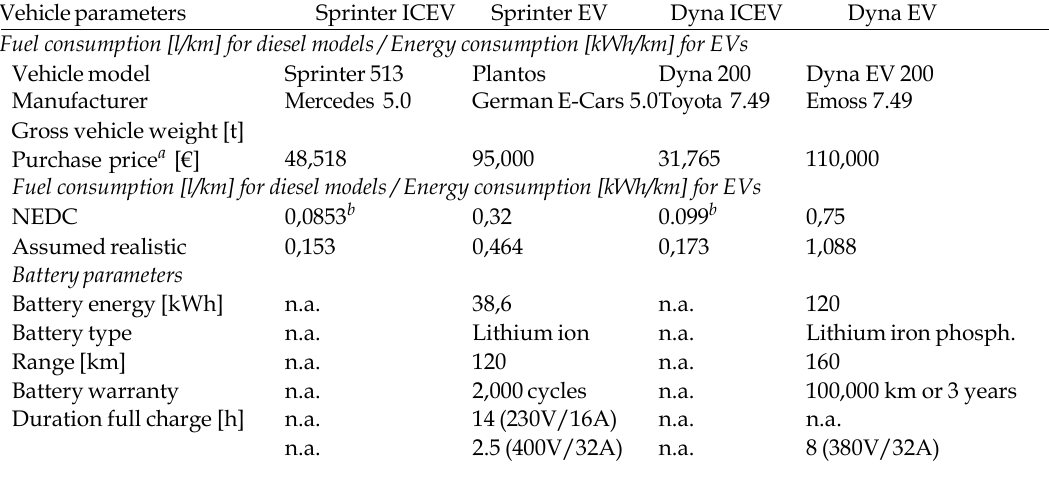
Table 3. Details on the compared vehicle